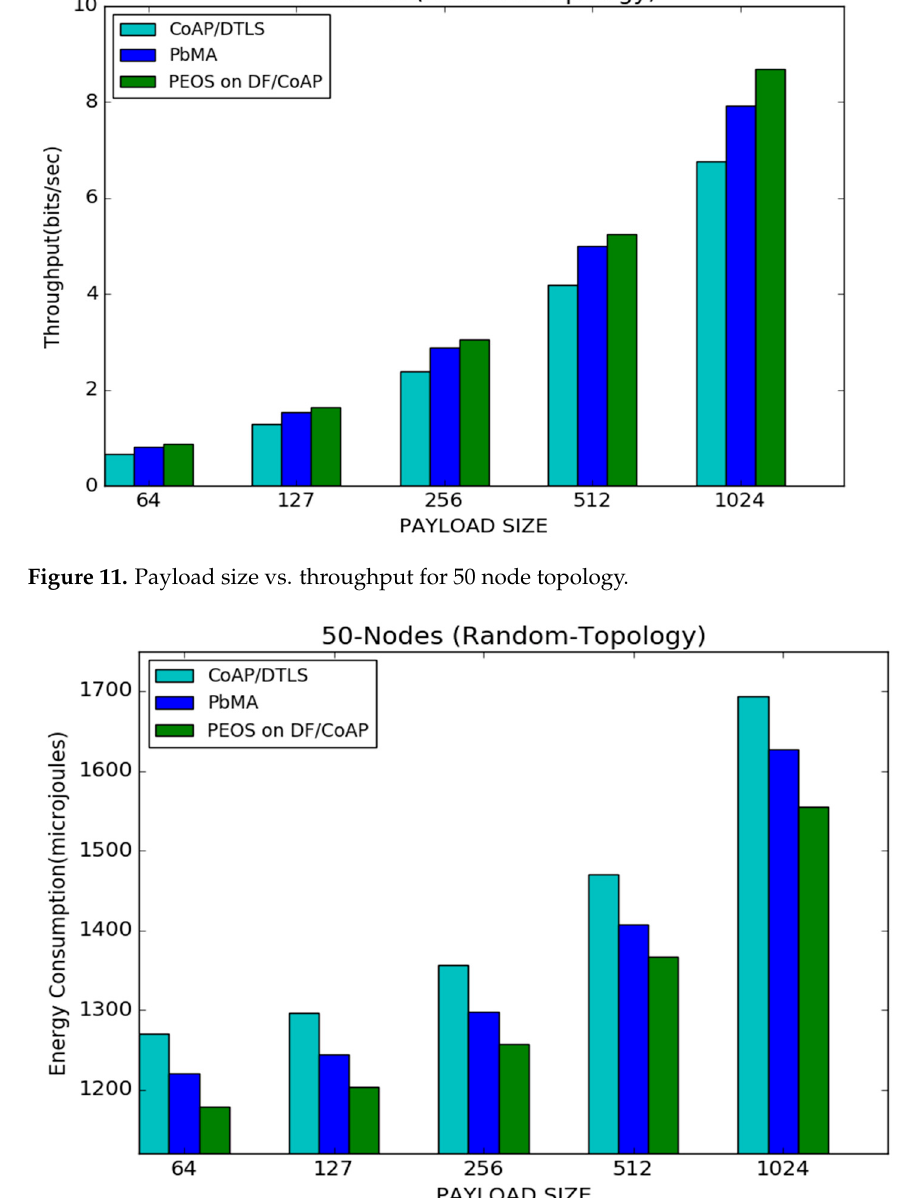
Figure 12. Payload size vs. average energy consumption for 50 node topology.